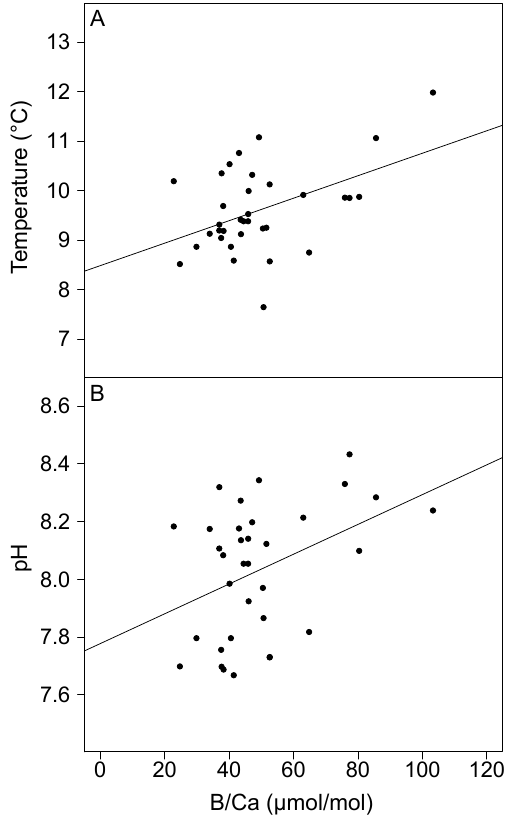
Fig. 8. (A) Relationship between M. californianus B/Ca from the inner prismatic layer and measured temperature (Adj. R 2 = 0 . 189, p = 0 . 0059). (B) Relationship between M. californianus B/Ca from the inner prismatic layer and measured pH (Adj. R 2 = 0 . 135, p = 0 .